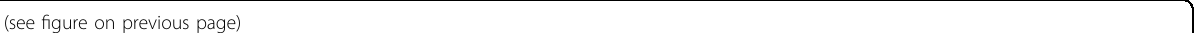
Fig. 2 Single-cell RNA-sequencing analysis of human healthy control, KBD chondrocyte and OA chondrocyte tissue samples. A Visualisation of clustering by t-SNE plot of all combined healthy control, KBD and OA samples, identi fi ed by cell type. B T-SNE plots demonstrating the gene expression of previously described markers used to identify the cell identity of each cluster: S110A4-prehypertrophic chondrocytes; CTNNB1- regulatory chondrocytes type 1; MMP13- hypertrophic chondrocytes; FRZB- effector chondrocytes; CHI3L1-regulatory chondrocytes type 2; NGF- proliferative chondrocytes; MT1X-homeostatic chondrocytes; OLFM2- fi brocartilage chondrocytes; STMN1-cartilage progenitor cells. Dot colour corresponds to the gene expression level in each cell. t-SNE, t-distributed stochastic neighbour embedding. C Heat map of scaled gene expression data for the top 5 differentially expressed genes identifying each cluster, with selected genes listed. t-SNE, t-distributed stochastic neighbour embedding. D t-SNE plot of cells according to disease status; different clusters contained different numbers of cells from KBD, OA and control samples. E Mean percentage of total cells that comprised each cell type, comparing control, KBD and OA samples. Bars indicate the percentage of total cells. F Representative immunohistochemistry staining of MT-ND1 and MT1X in KBD cartilage tissues. Scale bar, left, 500 μ m; right, 50 μ m, and quanti fi cation of positive cells of different areas (super fi cial, middle, deep) in cartilage tissues displayed by box plot ( n = 5). * p <